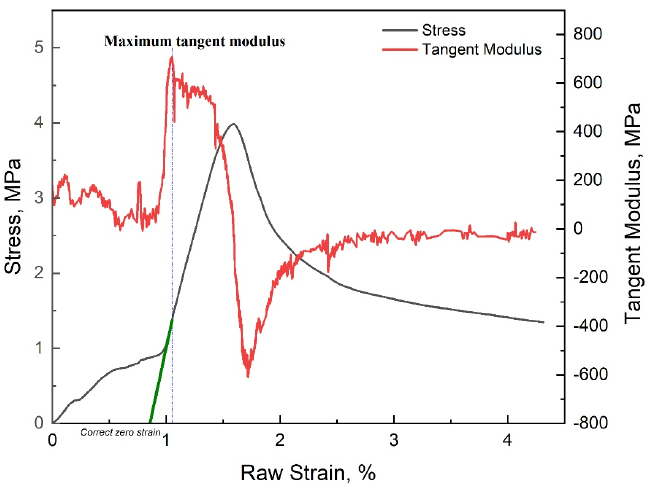
Figure 7. Correction of stress-strain curve in ductile regime.